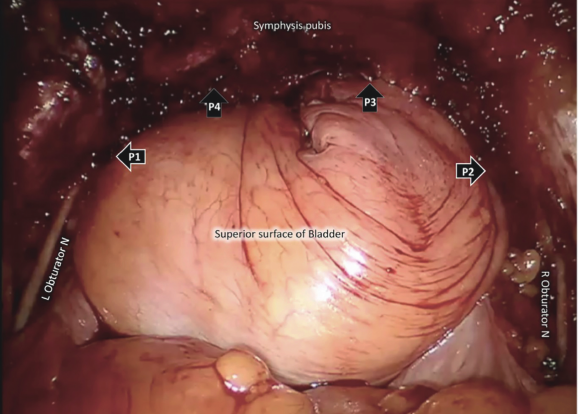
Figure 3 – Status following completion of four-point peritoneal flap fixation (P1, P2, P3, P4). The obturator nerves on both sides can be visualized